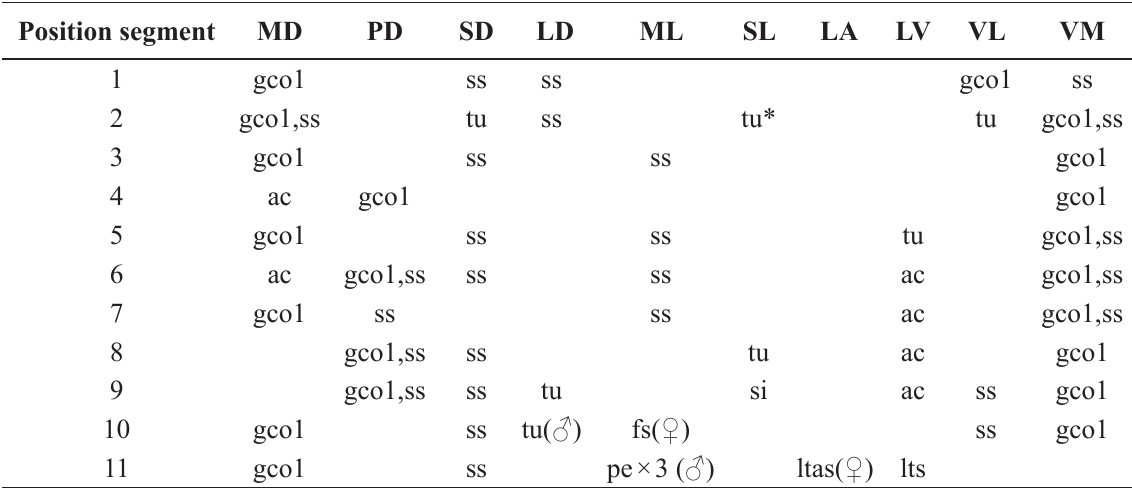
Table 7. Summary of nature and location of sensory spots, glandular cell outlets, tubes and spines arranged by series in Echinoderes dalzottoi sp.